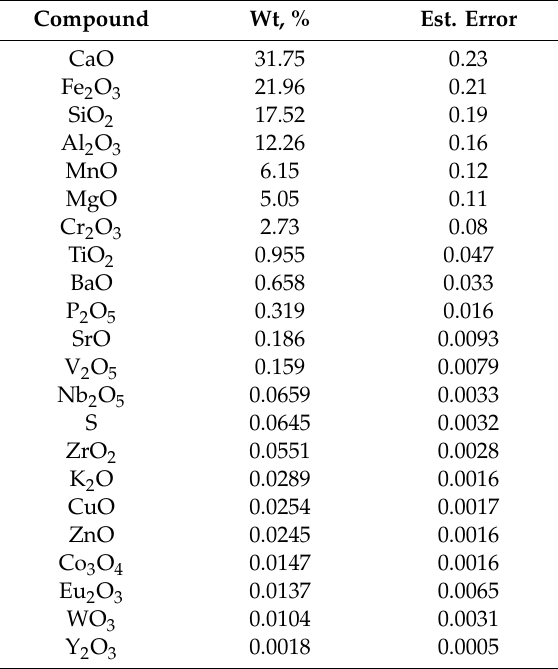
Table 8. X-ray fluorescence of electric arc furnace slag.